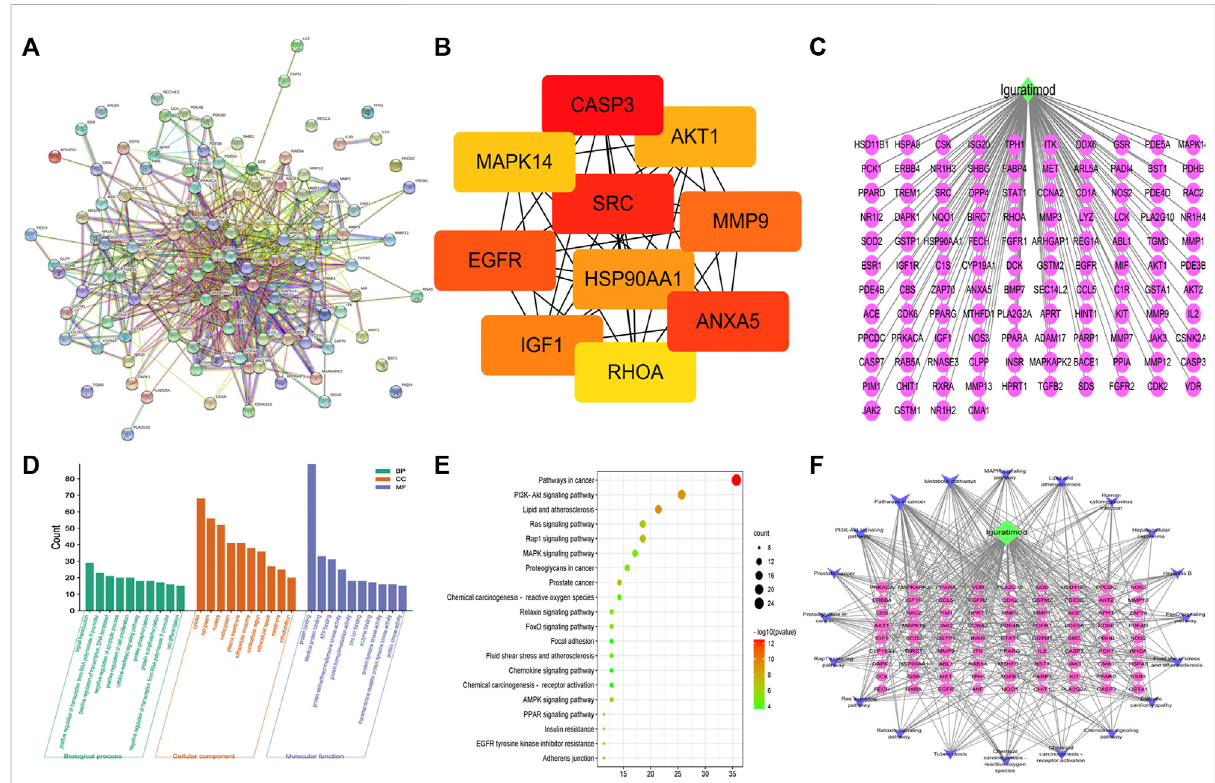
FIGURE 3 Bioinformatics analysis of overlapping targets. (A) Protein – protein interaction (PPI) network (B) Top 10 hub genes in the PPI network. ( C ) IGU - PACS potential target network. (D) Bar chart of GO enrichment analysis of the hub target of IGU in the treatment of SLE (the top 10 items); (green) biological processes, (orange) cell components, and (purple) molecular functions. (E) Bubble chart of KEGG analysis of the hub target of IGU in the treatment of SLE (the top 20 items). (F) Network of KEGG (the top 20 items) signaling pathway genes; (blue) pathway, (green) IGU , (yellow) four hub genes relevant to pathways and SLE, and (purple) potential